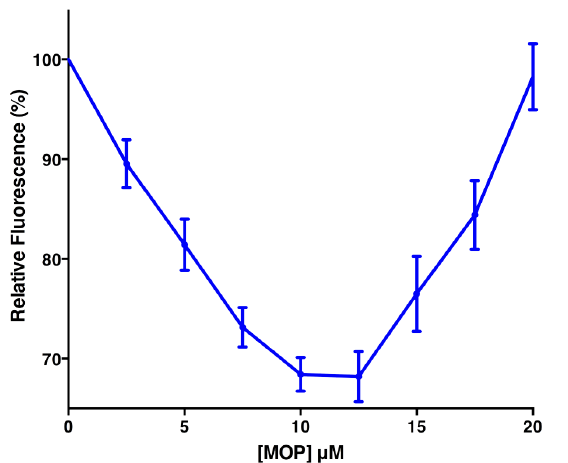
Figure 4. Effect of MOP on fluorescence emission of NPN bound to AaegOBP1. Emission maxima were normalized to display mean ± SEM from three experiments. MOP dissociation constant was calculate for the decreasing phase (0–12.5 µM). Note the increase in fluorescence emission